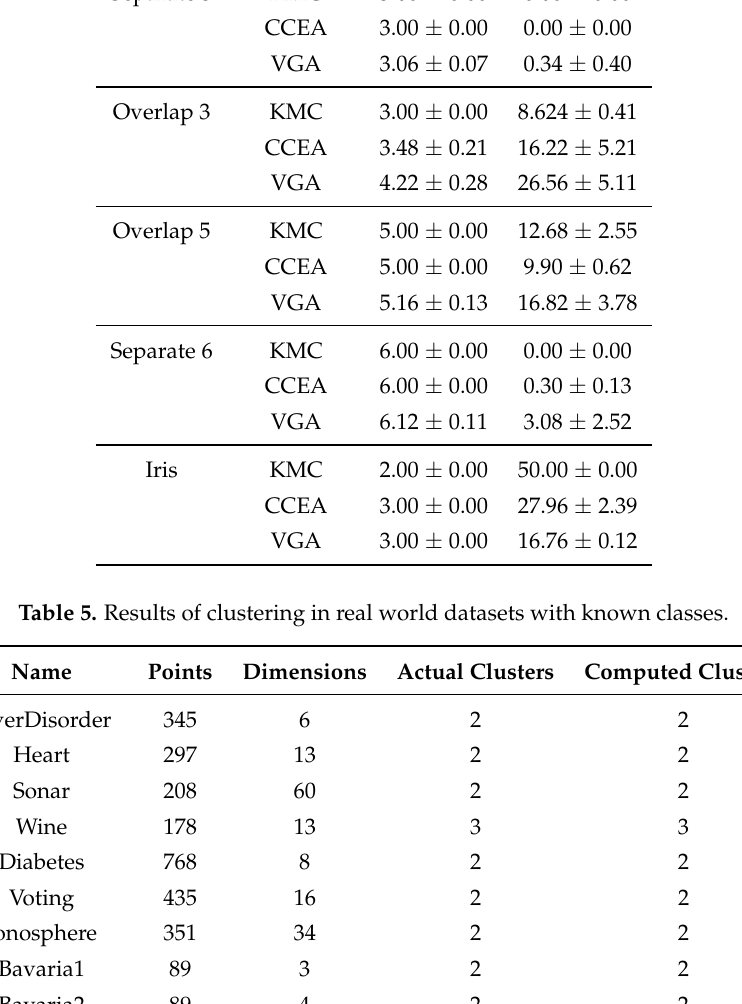
Table 6. The KMC method could obtained the exact number of cluster for both datasets as stated in Table 6. Figure 8 shows the performance of the KMC method in improving the misclassification errors for these datasets. The average misclassification errors for Hill-Valley and LSVT datasets are 14.95% and 27.98%,